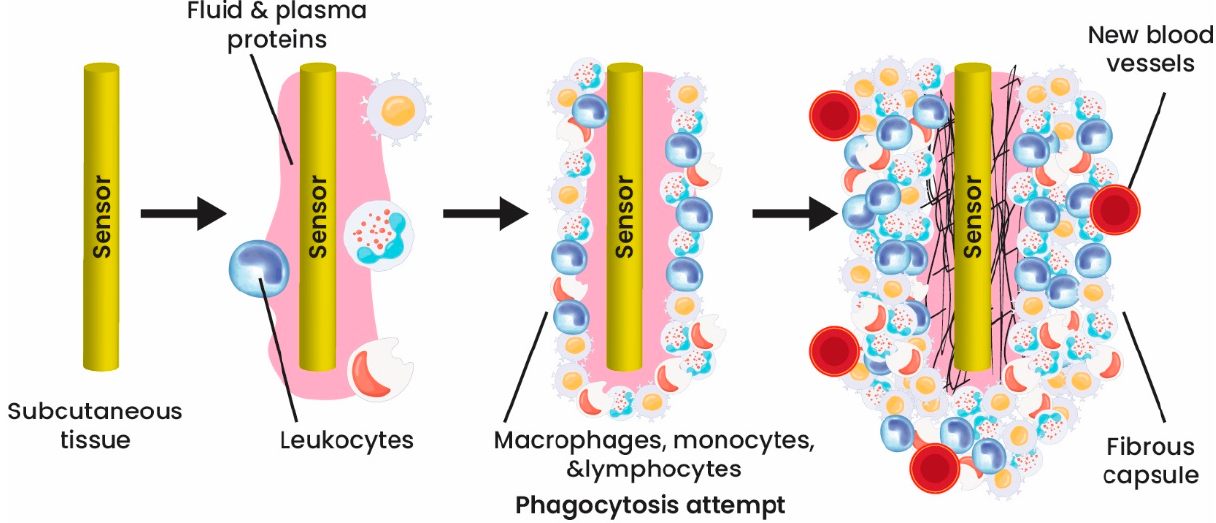
Figure 4. Formation of a fi brous capsule following the implantation of a biosensor in tissue.